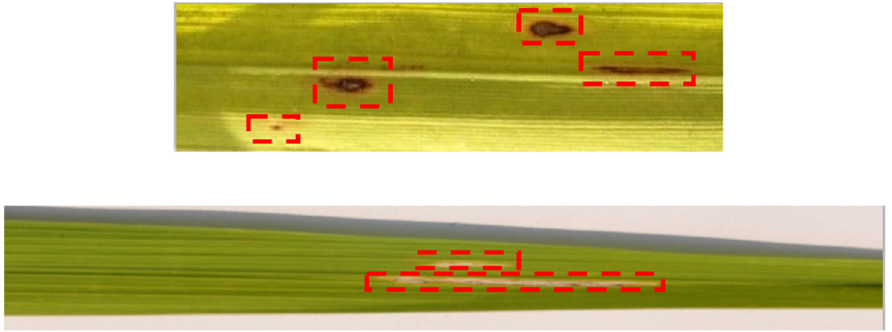
Figure 8. Observing Margins for defective regions.